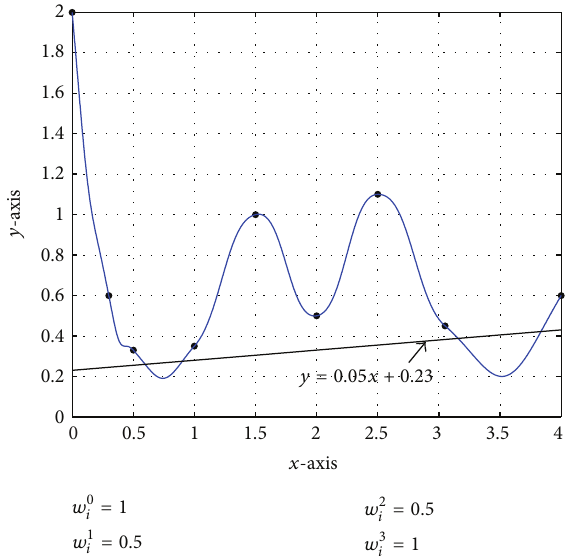
Figure 11: Rational cubic trigonometric curve lying below the given line.